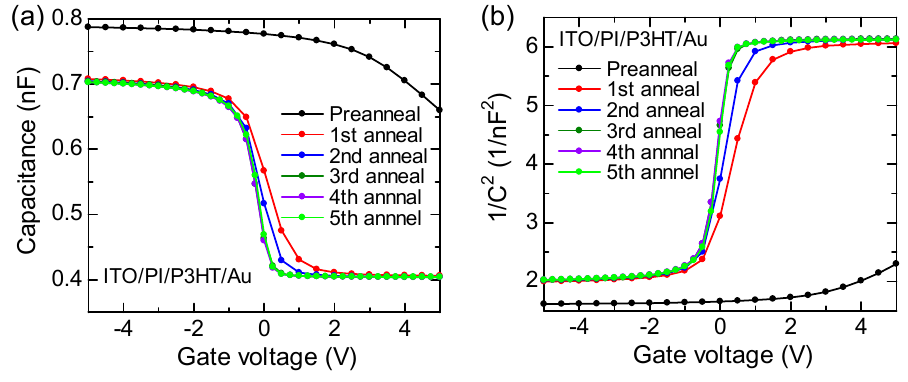
Figure 5. ( a ) Gate voltage dependences of the capacitance ( C ) and ( b ) 1/ C 2 -gate voltage plots in the ITO/PI/P3HT/Au MIS capacitor without the peripheral regions measured at 100 Hz after each thermal annealing cycle.